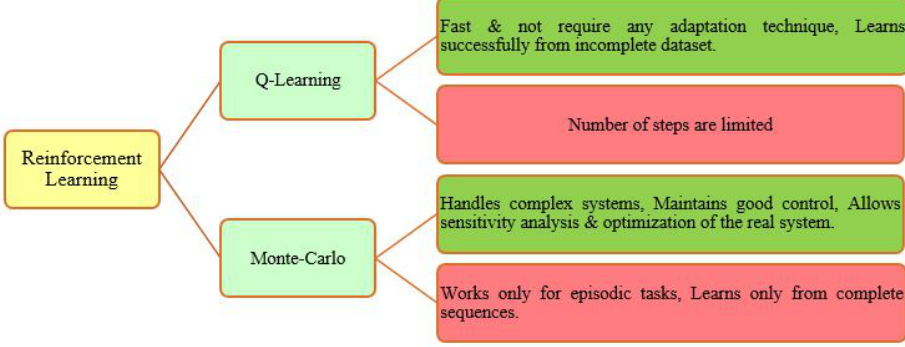
Figure 12. Pros. (Light Green) and Convs. (Light Red) of Reinforcement learning models [78,82].